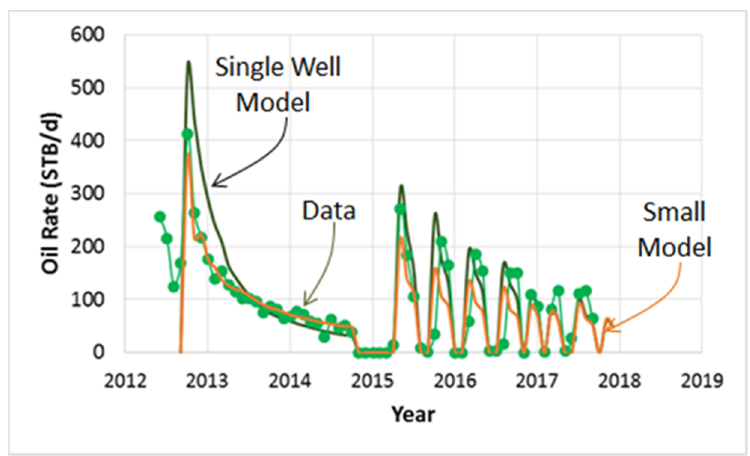
Figure 9. History-match results for both single-well model (black) and quarter-fracture model (orange).